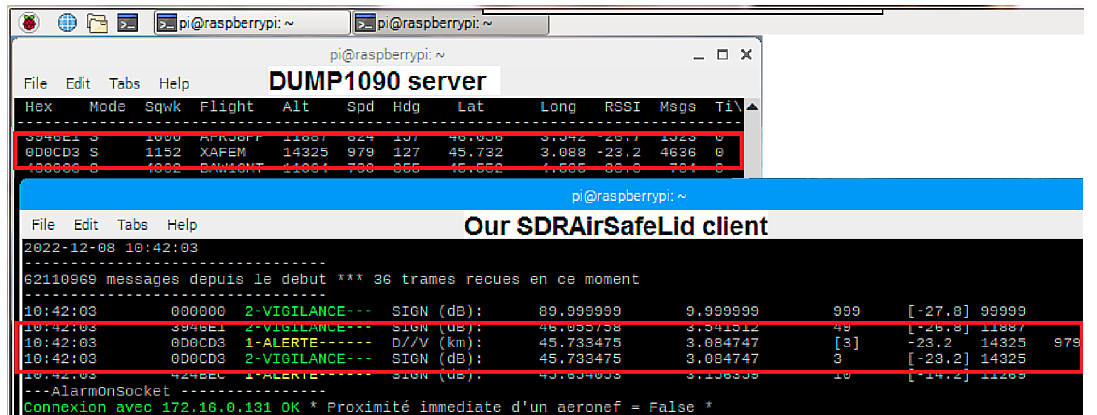
Figure 3. RaspberryPi screenshot illustrating software in use: DUMP1090 “server” (top) and SDRAirSafeLid “client” (bottom).